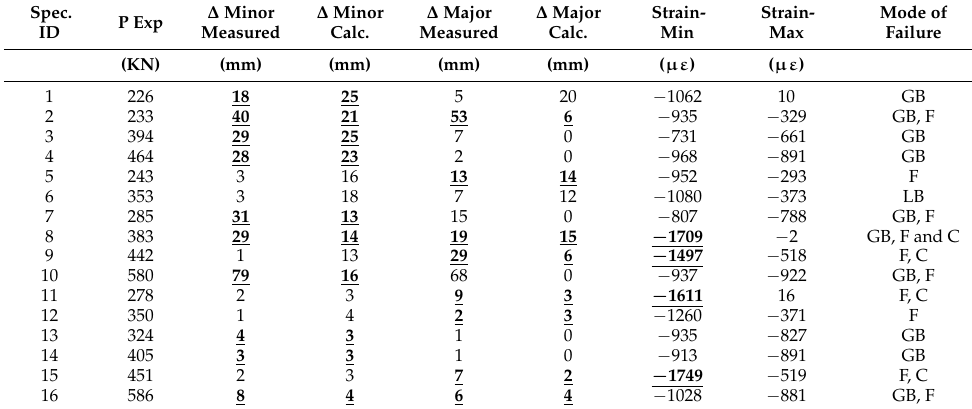
respectively. Negative strain and positive strain values correspond to compressive stresses and tensile stresses, respectively. Figure 4 shows the failure modes of tested specimens. Table 5. Summary of experimental program results.